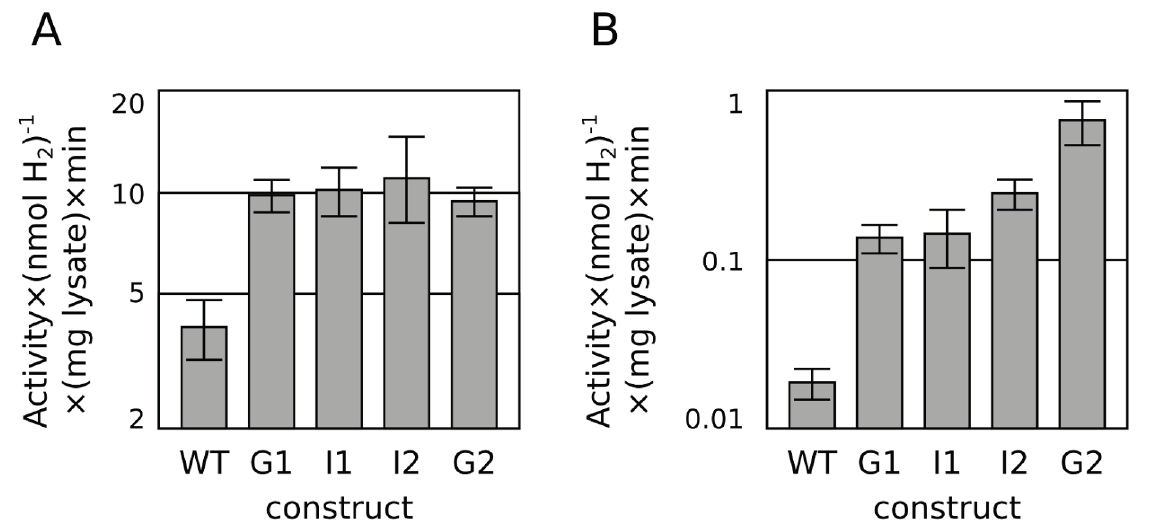
Figure 2. Methyl viologen-mediated ( A ) and methyl viologen-free (dithionite only) ( B ) in vitro hydrogen production assay from extracts of E. coli over-expressing the WT hydrogenase, G1 hydrogenase, and progressive substitutions to G2 hydrogenase (see Table 1 for sequence identities). Activities are plotted on a log scale over a 10-fold and 100-fold ranges, respectively to compare fold